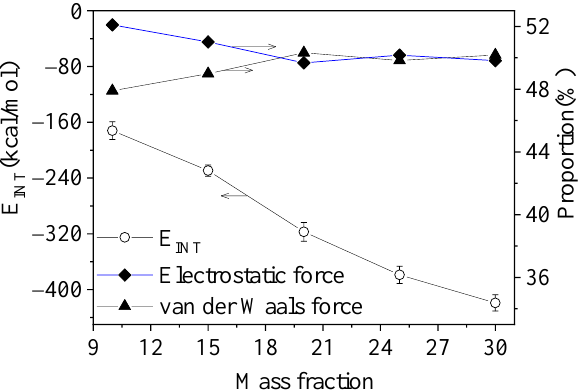
Figure 5. The relationship between the interfacial binding energy, the electrostatic force, and van der Waals force with the mass fraction of thermoplastic starch.